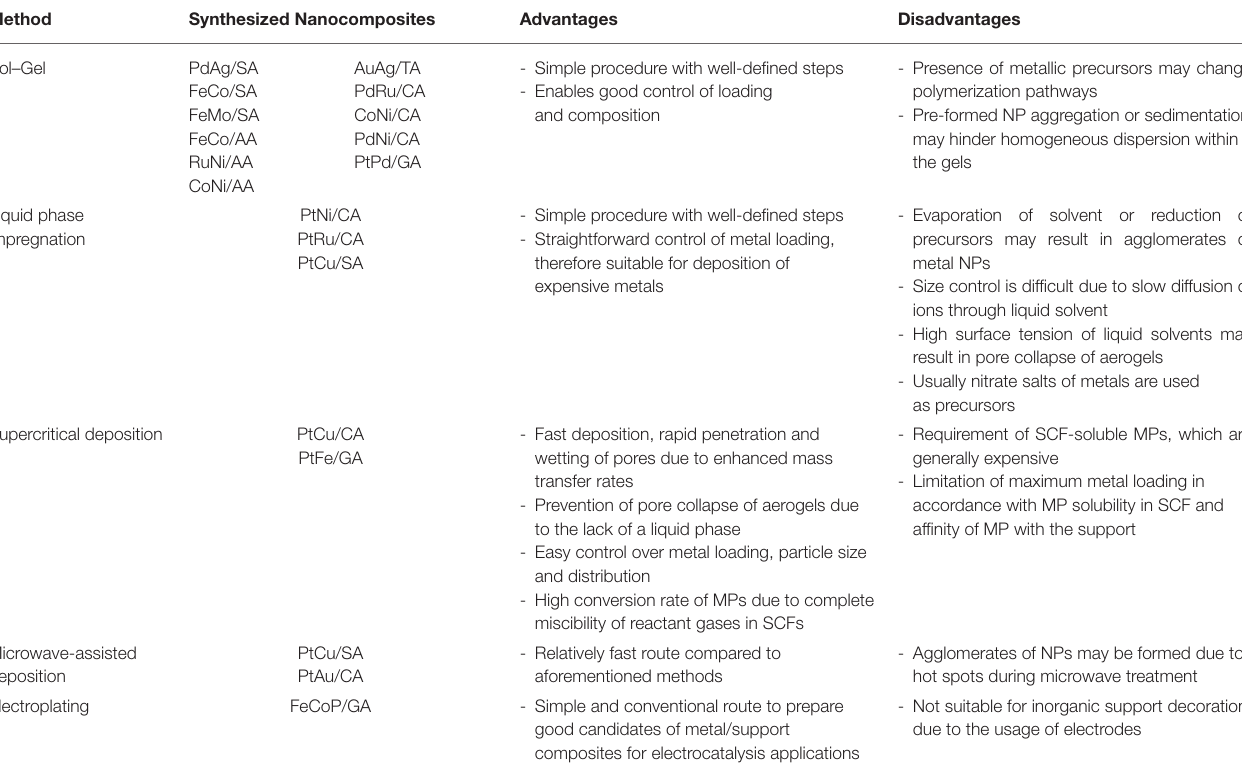
TABLE 1 | Advantage and disadvantages of aerogel supported bimetallic nanoparticle synthesis